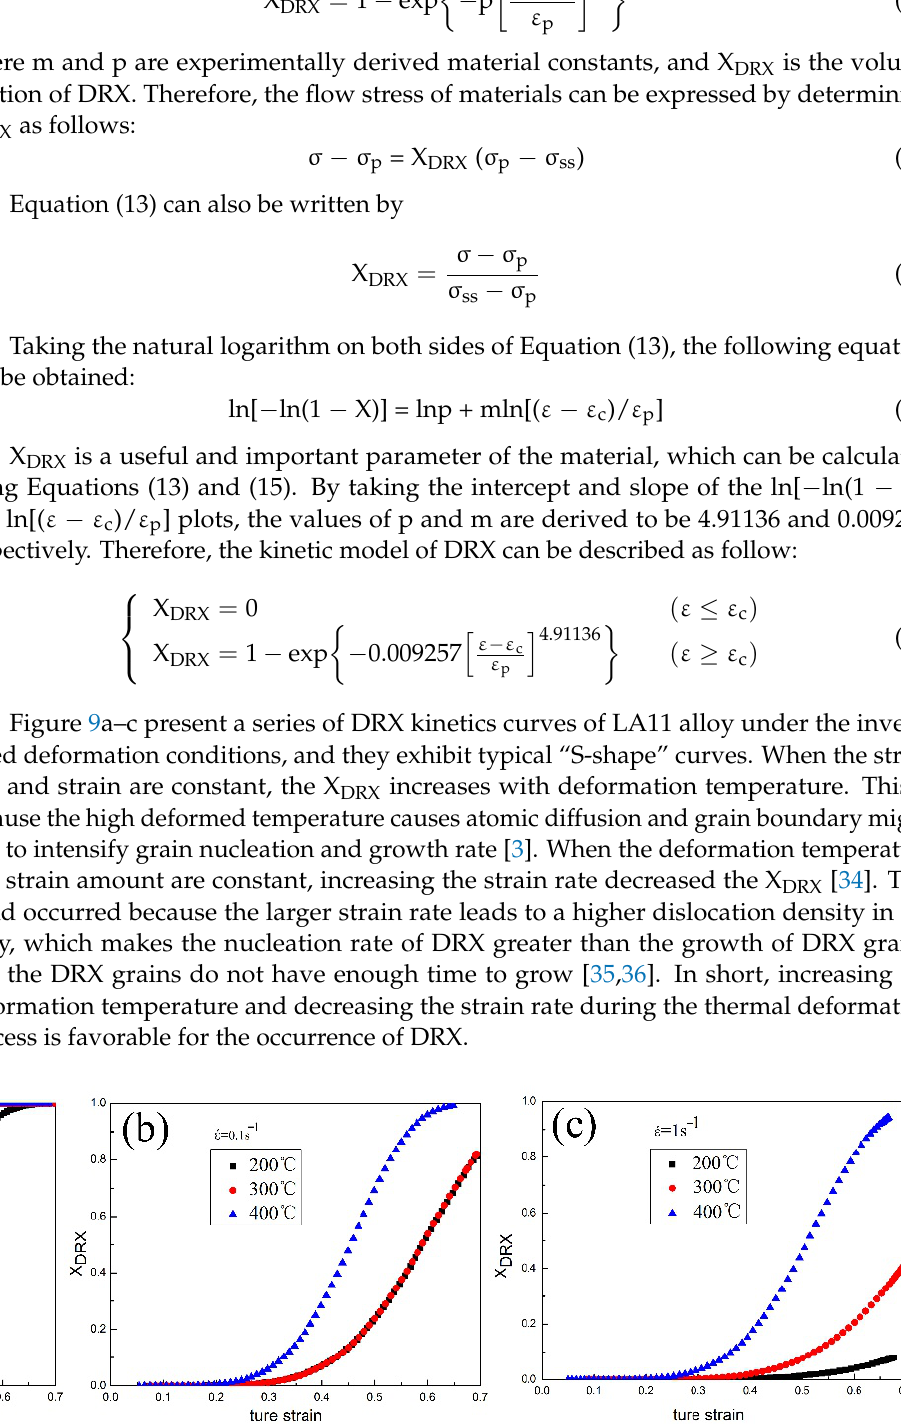
Figure 9. Predicted volume fraction of DRX obtained at different temperatures and strain rates.